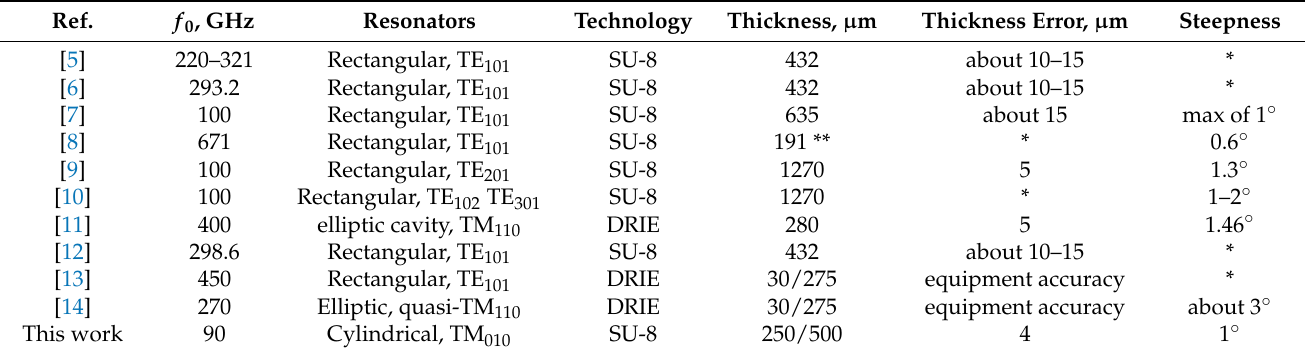
Table 1. Recently published waveguide filter operating at frequencies above 90